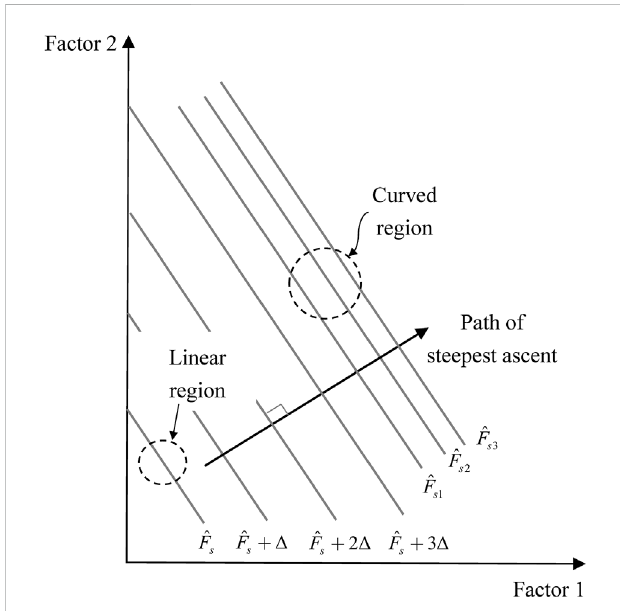
Schematic diagram of the steepest ascent path in the “ curved ” response